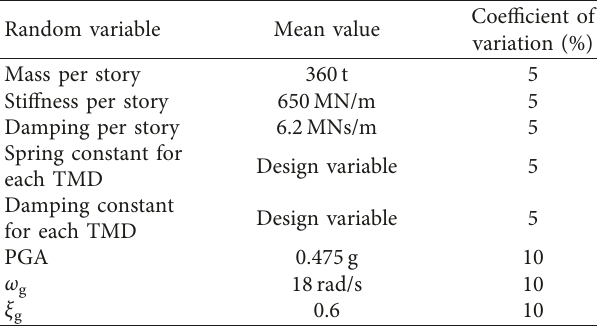
Table 1: Mean value and coefficient of variation of each input random